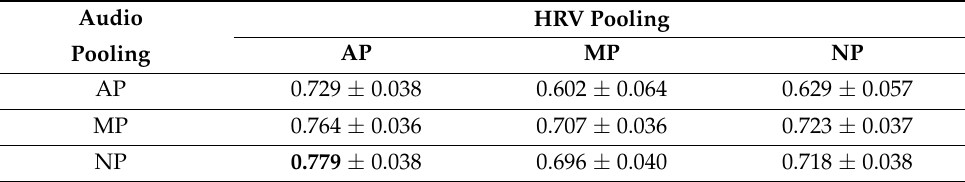
Table 18. Average ROC-AUC scores for the discrimination between stable and anomalous (pre- relapsing or relapsing) patients’ condition, depending on the temporal pooling per